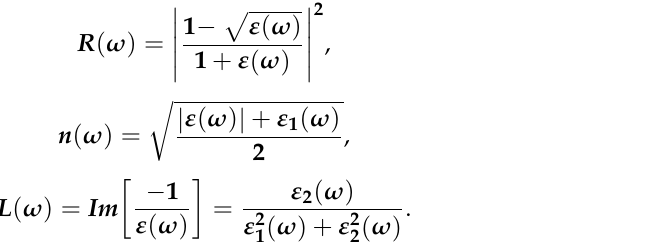
Table 6. Calculated optical properties without and with scissor operator (SO) of pure Ga 2 O 3 and Sr-doped β -Ga 2 O 3.